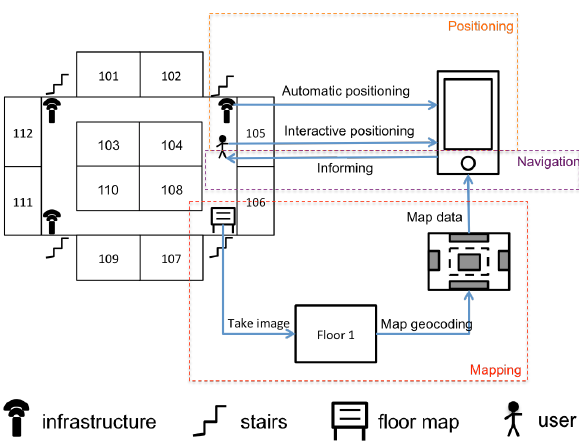
Figure 6. Framework of cognitive indoor navigation